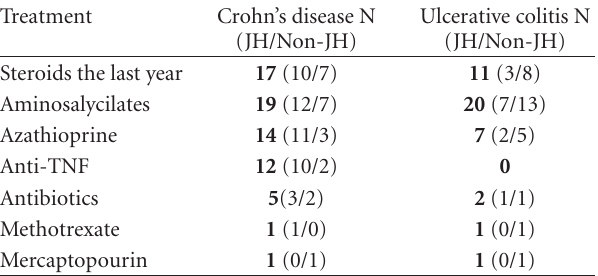
Table 4: Medication of IBD patients in relation to Joint Hypermo- bility. A number of patients were on combination treatment (data not